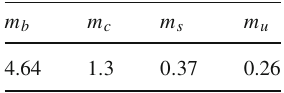
F F ( 0 ) a b f s 0 . 488 1.04 0.38 1 − 0 . 180